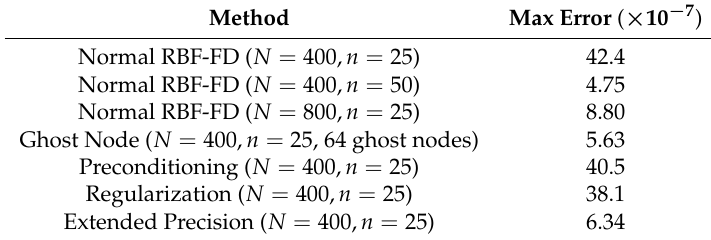
Table 3. The results of solving the PDE Equation (20) by using the RBF-FD method at a shape parameter equal to 0.4 with different additional